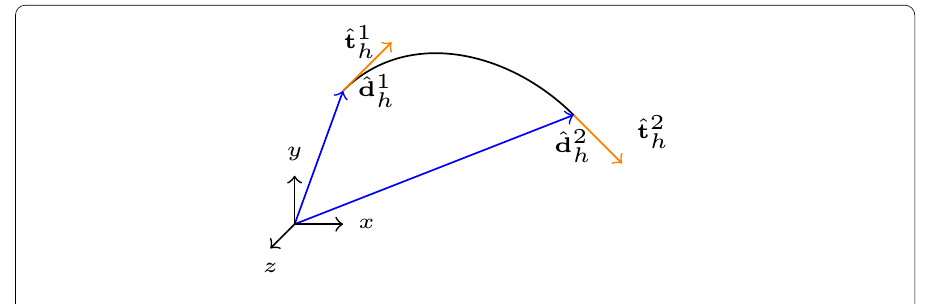
Fig. 3 Visualization of a Hermite beam centerline interpolation